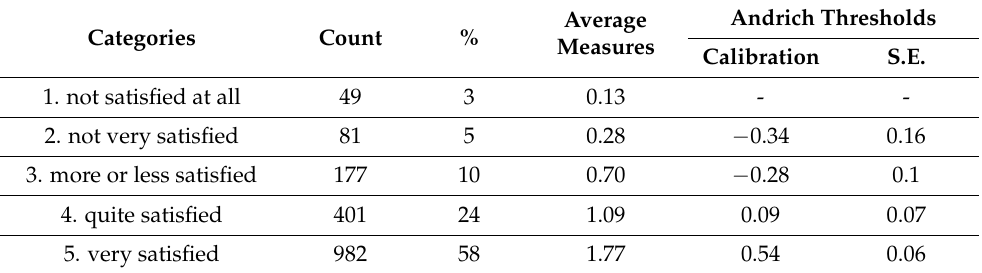
Table 2. Structure of the QUEST 2.0–device categories.